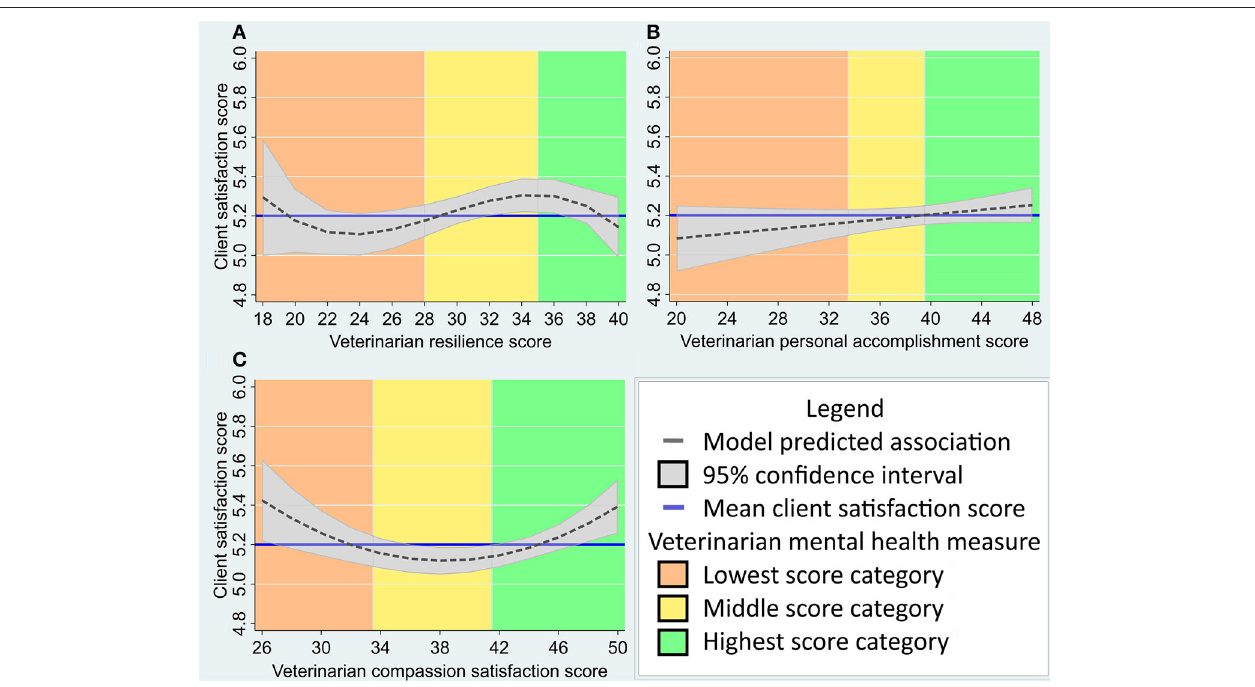
FIGURE 2 | (A–C) Predicted association between veterinary client satisfaction (as measured by the Client Satisfaction Questionnaire, n varies from 823 to 995 as described in results) and veterinarian mental health measures ( n = 60) in a multivariable, multilevel linear regression model. Veterinarian mental health measures include: (A) Connor-Davidson Resilience Scale score; (B) MBI-HSS Personal Accomplishment subscale score; and (C) ProQOL Compassion Satisfaction subscale score. Mean client satisfaction score and mental health measure categories (as described in methods) are provided for reference. The Y-axis has been standardized to include the interquartile score range for this population (4.9–5.9) and the X-axis has been adjusted for the range of scores seen in this